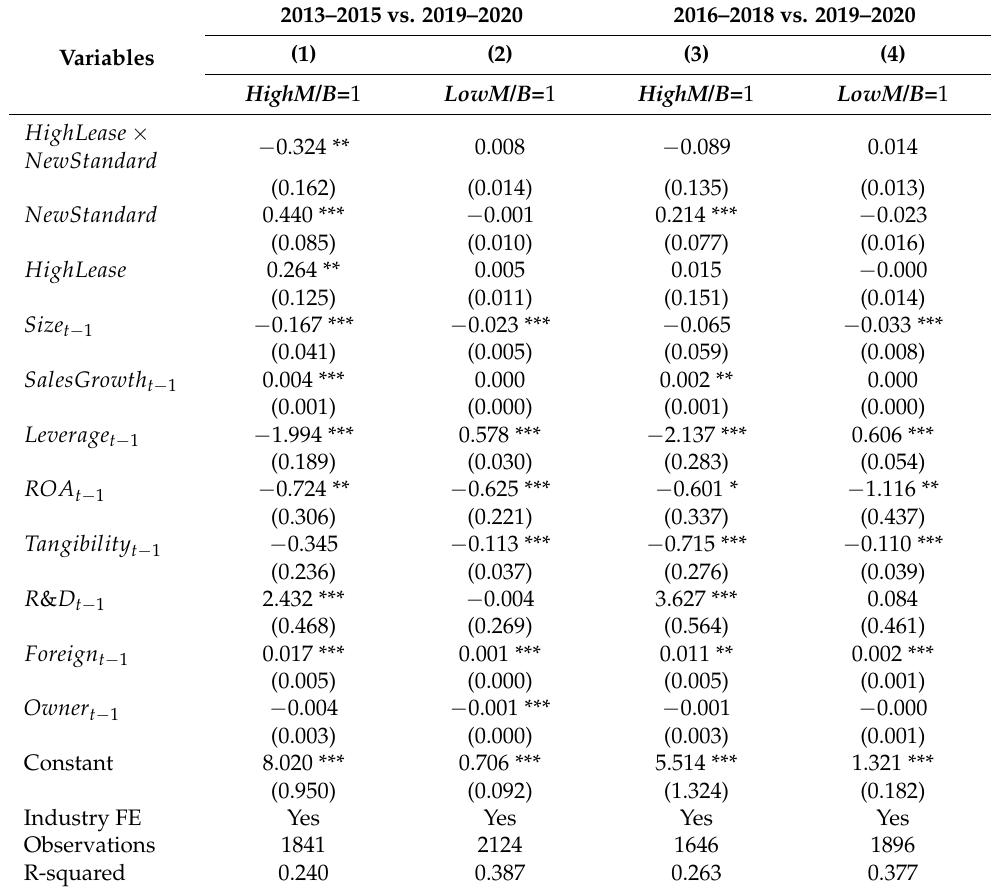
Table 7. Growth opportunity and the effect of K-IFRS 1116 on firm value. This table documents the effect of K-IFRS 1116 on firm value for the subsamples categorized by the M/B. The dependent variable is Tobin (cid:48) s q . Standard errors are clustered at the firm level and are reported in parentheses. *, **, and *** denote statistical significance at the 10%, 5%, and 1% levels,